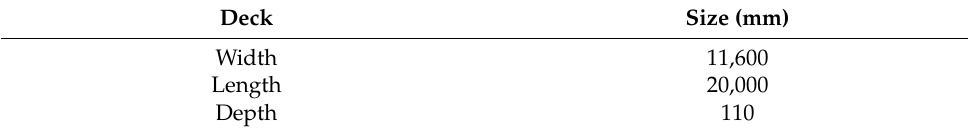
Table 3. Dimensions of the aluminum deck.